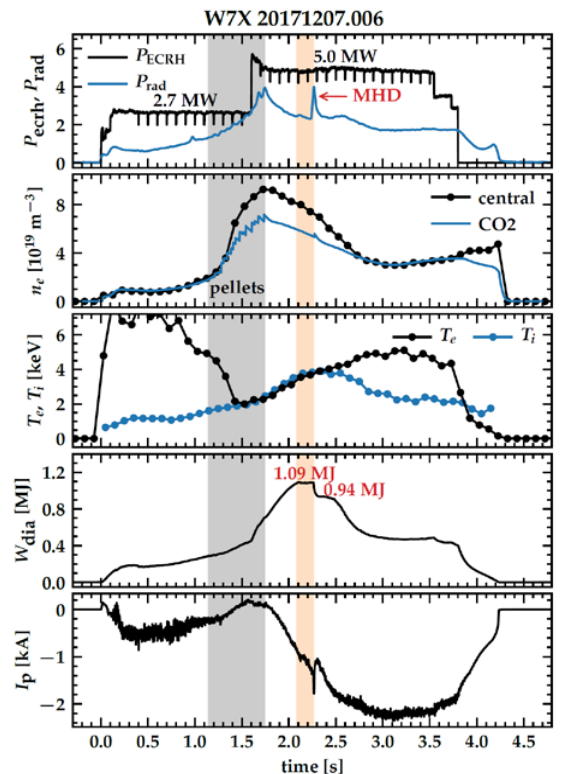
Fig 4: High performance discharge with record beta and triple product. At the top there is the ECRH power and the radiated power. In the next boxes the central Thomson density and the line-averaged density followed by the electron temperature form the Thomson scattering and the ion temperature measured by the x-ray spectroscopy are shown. At the fourth row there is the